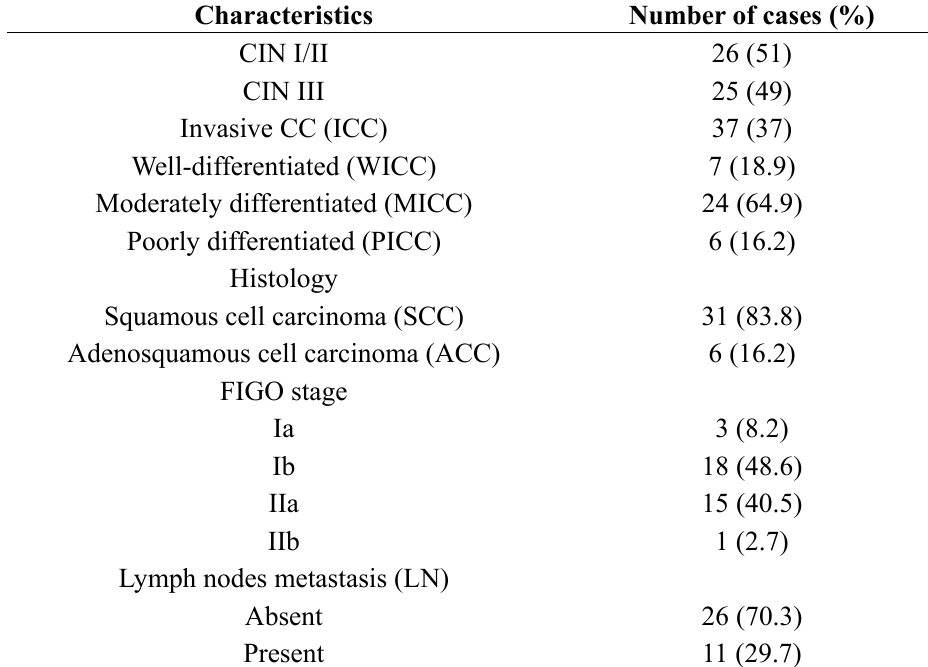
Figure 1. Immunohistochemical staining of HMGB1 in cervical samples. HMGB1 staining in cervical samples ( A – D ). The analysis showed HMGB1 expression in tumor cells was positively stained for nuclei ( A ); clear staining in CIN III ( B ); and potent staining in CIN